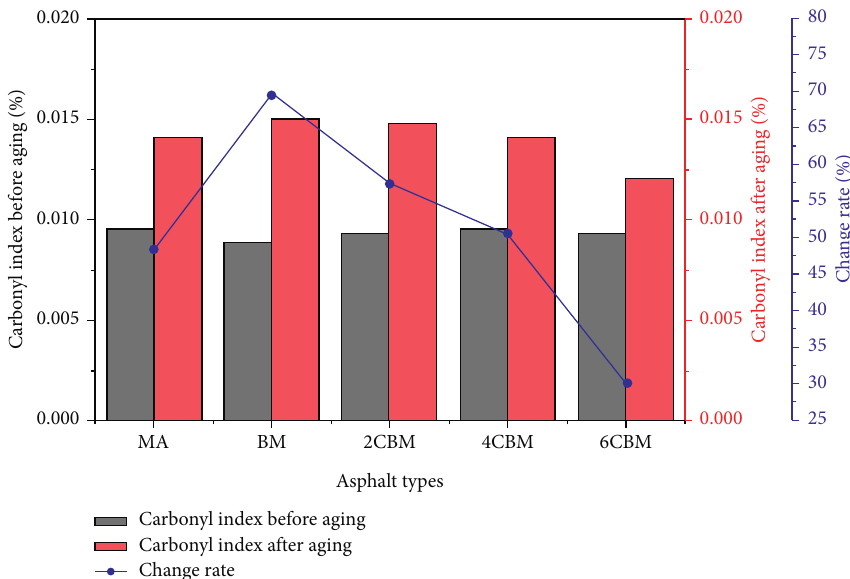
Figure 10: Effect of organic nano-CaCO 3 on carbonyl index (CI) of bioasphalt before and after aging.